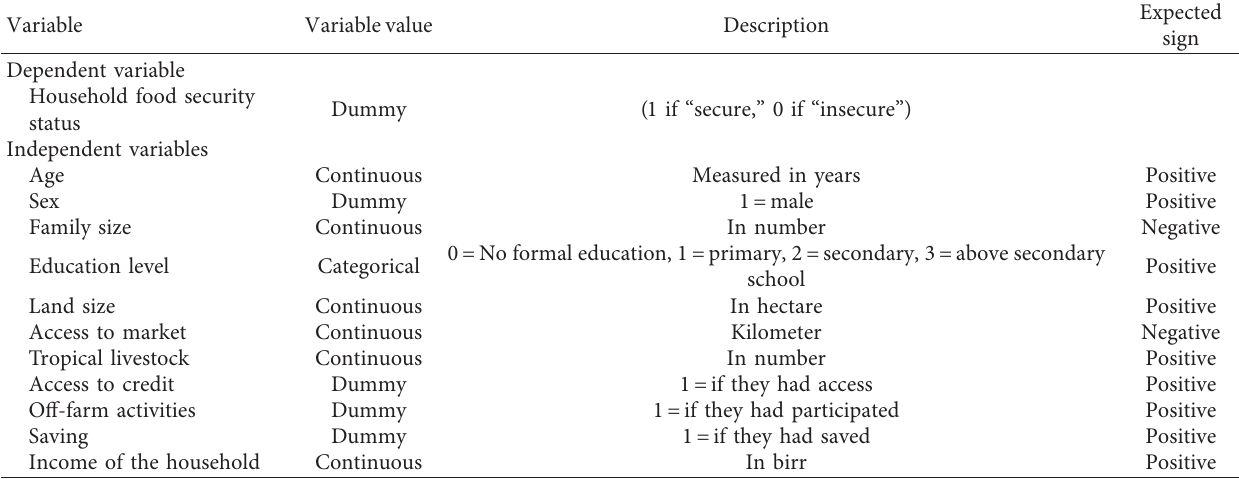
Table 1: Description, measurement, and expected sign of variables.